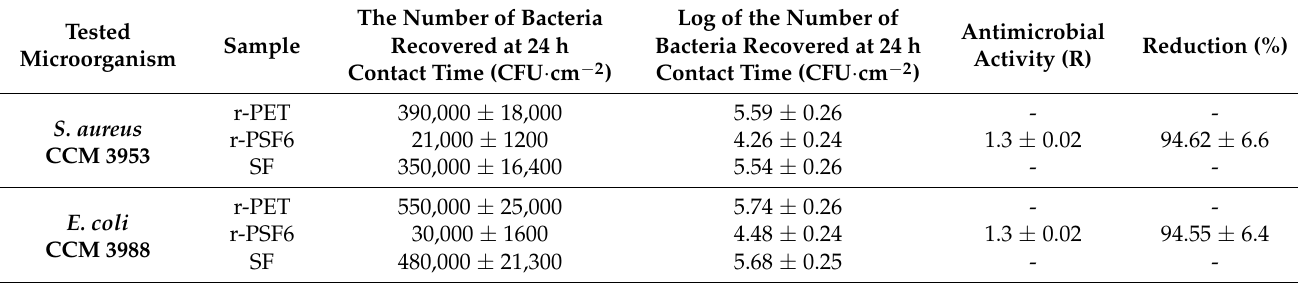
Table 8. Antibacterial activity of the investigated electrospun mats. The values are listed in the form mean ± SD. Tested